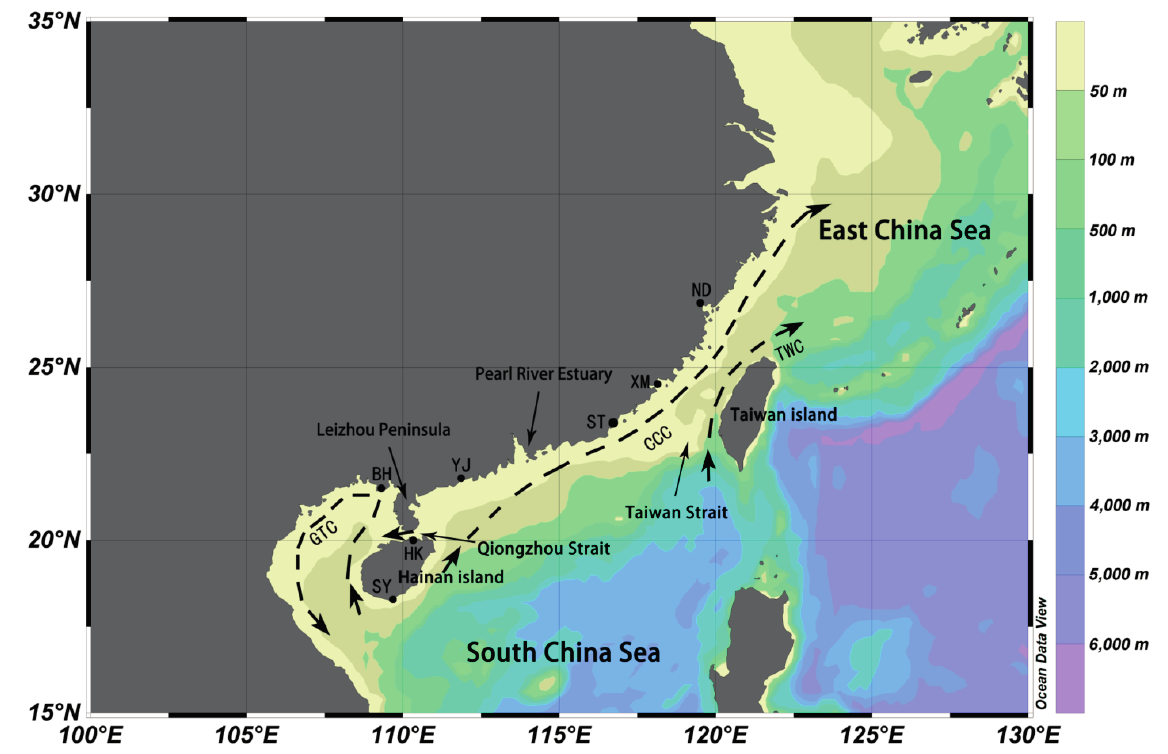
Figure 3. Map showing the seven sampling sites along the Chinese coast. CCC, China Coastal Current; TWC, Taiwan Warm Current; and GTC, Gulf of Tonkin